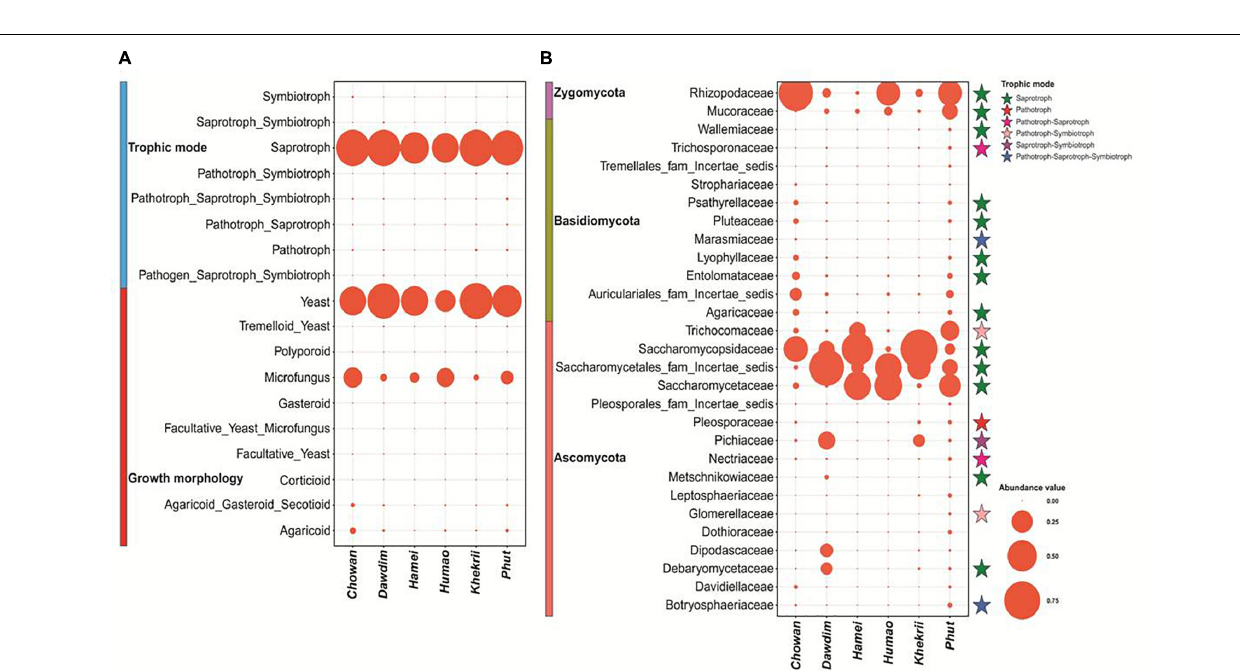
FIGURE 3 | Heatmap of OTUs showing (A) Core genus distribution pattern and (B) Core species and their relative abundance present in all samples.